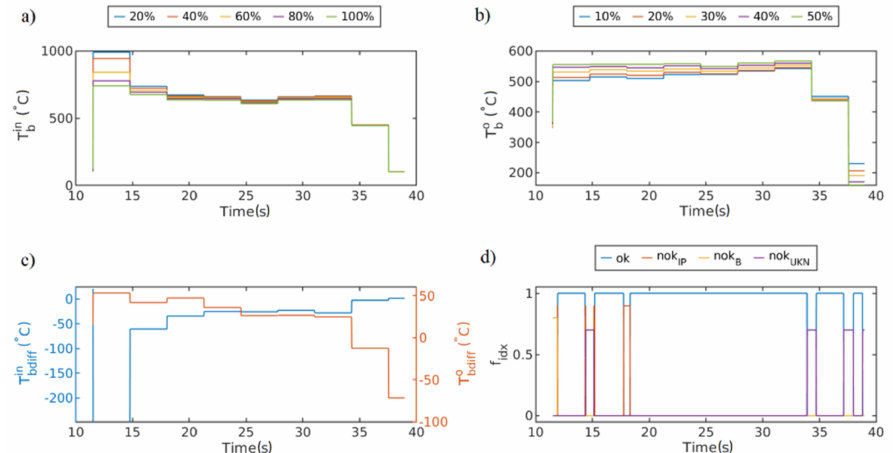
Figure 19. Feature and detection result for S13 using the interpolated IR sequence obtained using nearest neighbor interpolation with the interpolation factor = 196: ( a ) inner band temperature distribution T in , ( b ) outer band temperature distribution T in b ( d ) weld defect detection